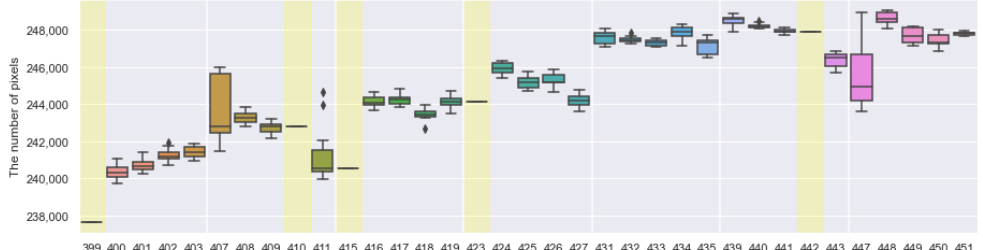
Figure A7. 24–30 September.